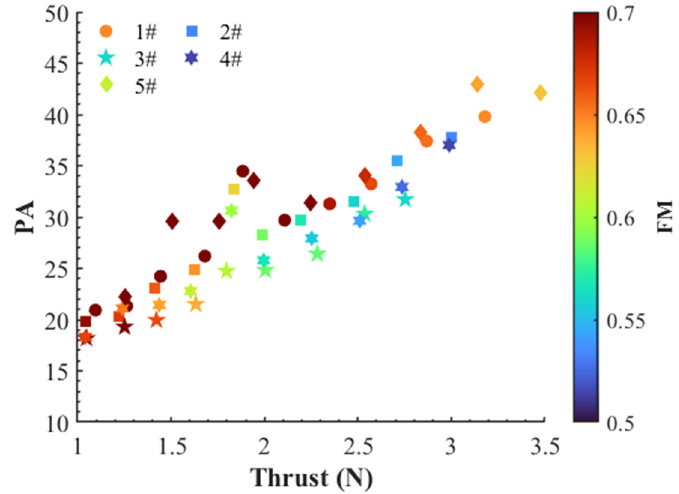
Figure 19. Mean psychoacoustic annoyance (Di’s model) vs. thrust and FM among the two-blade propeller (#1), four-blade propeller (#2), loop-type propeller (#3), wide chord loop-type propeller (#4), and DJI Phantom III propeller (#5) at a rotational speed of 3000–5700 rpm.